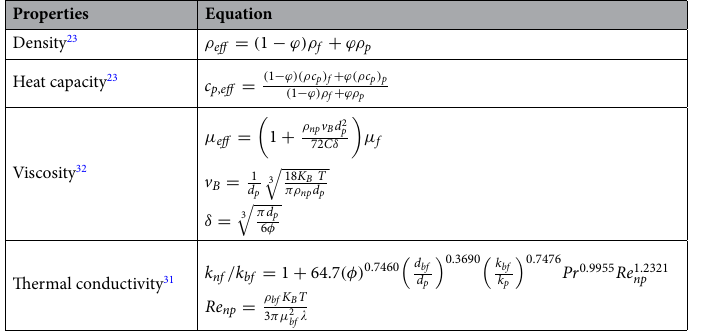
Table 1. Al 2 O 3 /water properties.